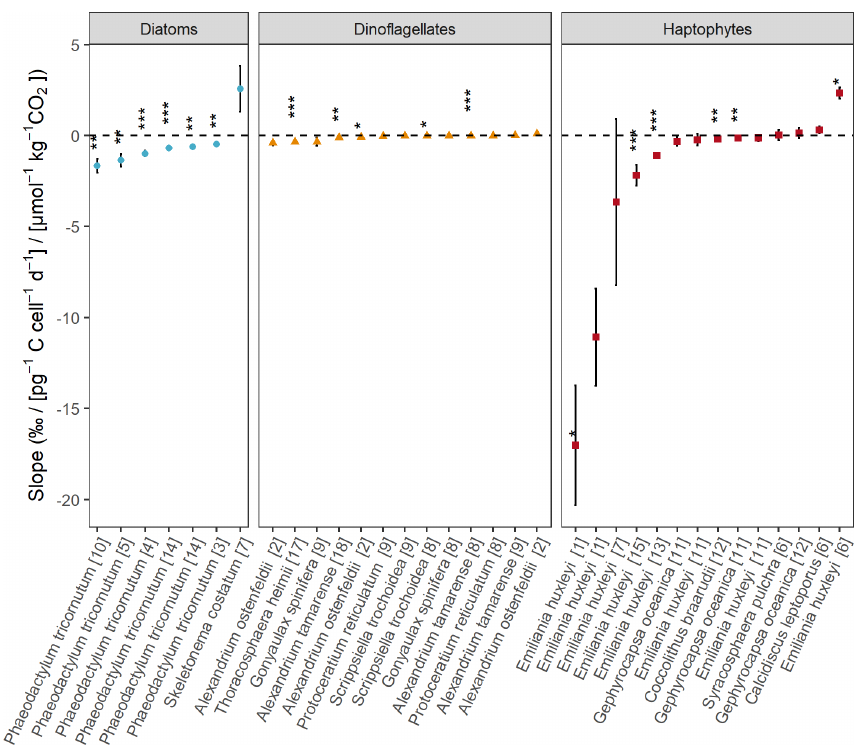
Figure 3. Slopes of ε p in response to POC production / [CO 2 ] for the different species and studies using a linear fit. Numbers between brackets refer to the different studies (Table S1). Blue dots represent diatoms, orange triangles dinoflagellates, and red squares haptophytes. Significance is indicated by the asterisks ( ∗∗∗ P < 0.001, ∗∗ P < 0.01, ∗ P <